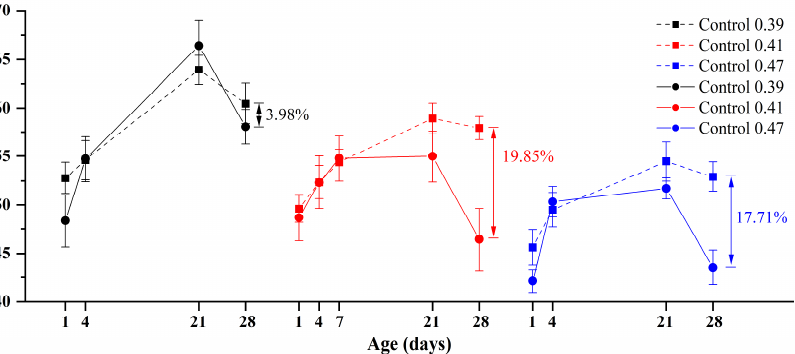
Figure 10. Compressive strengths of GA mortars with different w/b ratios under alkali curing at 80 °C (solid line) and water curing at 80 °C (dash line).